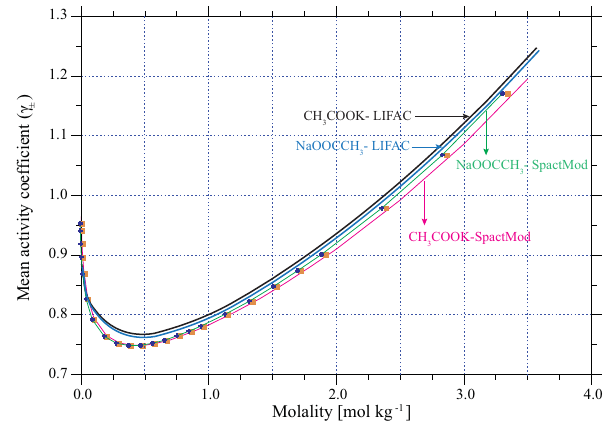
Figure 9. Comparison of modeled water activities for the aqueous solution composed of an organic-electrolyte mix- ture: (NH 4 ) 2 SO 4 + glycerol + H 2 O [(2:1:1) mole ratio]. The SpactMod results are in agreement with